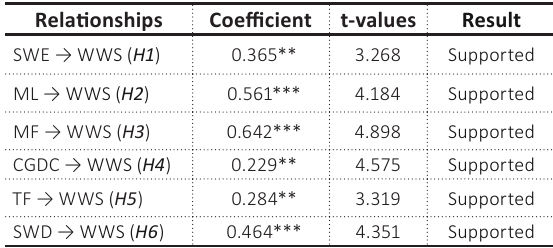
Table 4. Summary of hypotheses testing Relationships Coefficient t-values